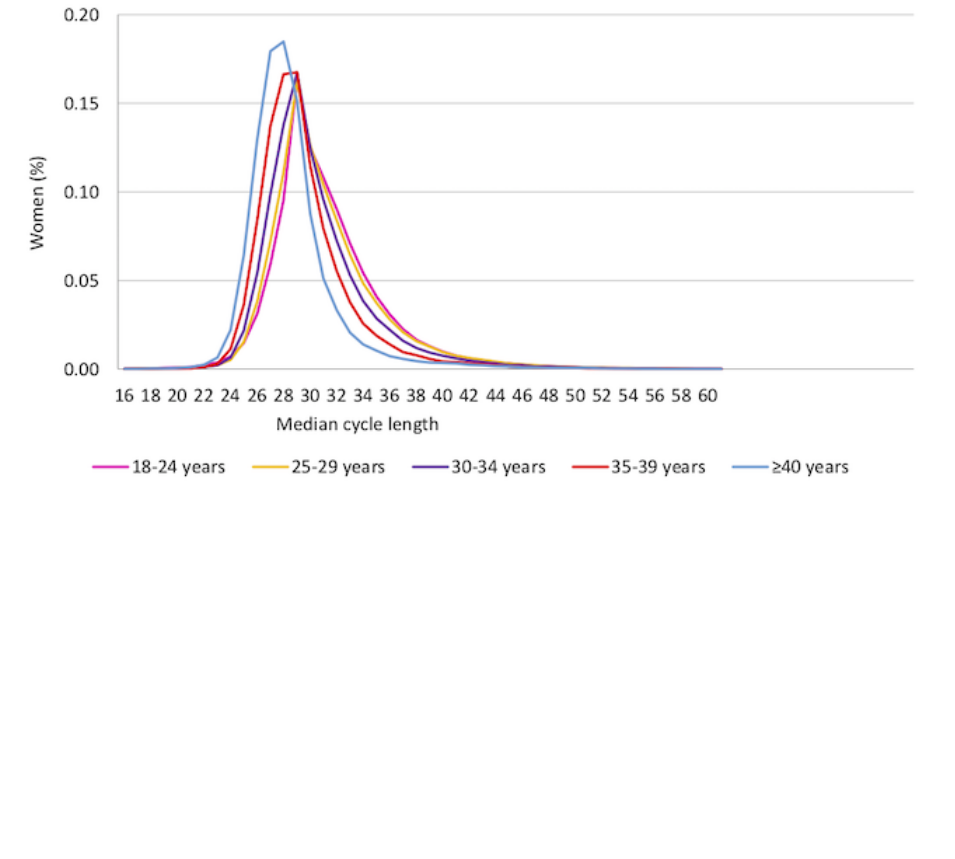
Figure 1. Median cycle length distribution by age